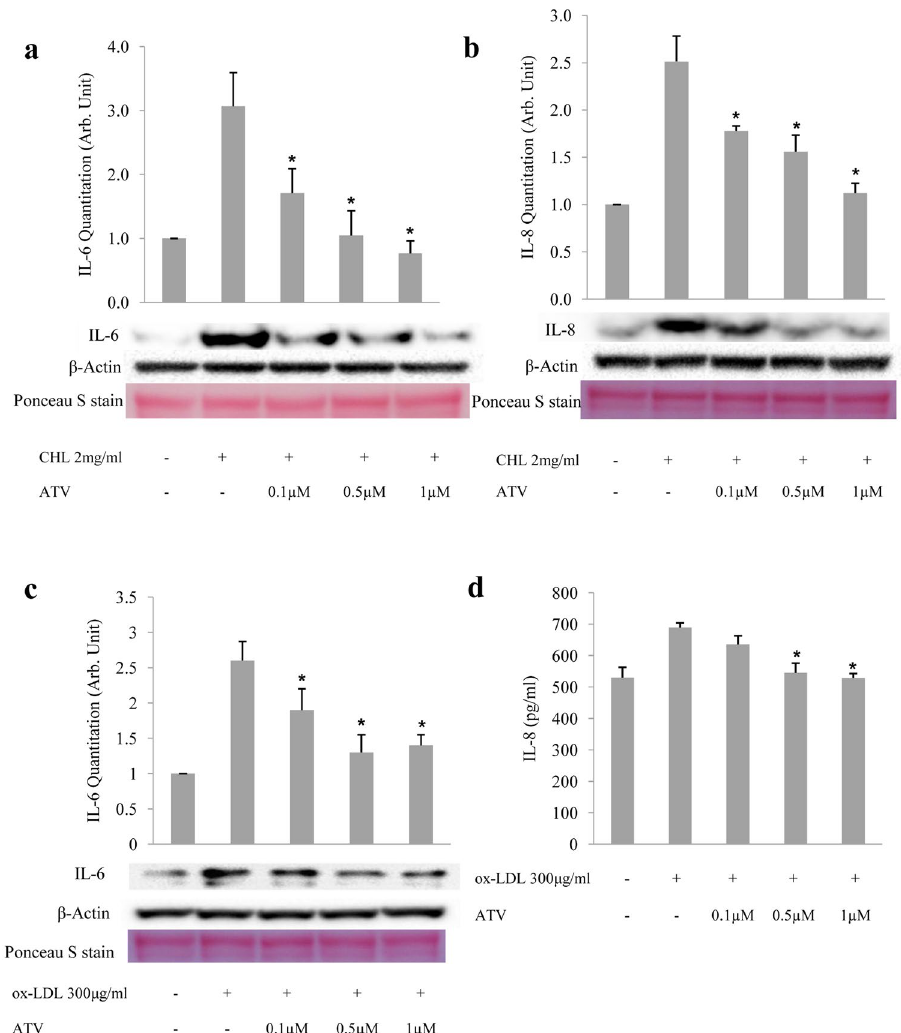
Figure 5. Atorvastatin inhibits IL-6 and IL-8 secretion induced by cholesterol crystals and ox-LDL in ARPE- 19 cells. IL-6 ( a ) and IL-8 ( b ) secretion from ARPE-19 cells as determined by western blot of equal volumes of culture medium 6 hours after treatment with 2 mg/ml of cholesterol crystals (CHL), with or without pretreatment with 0.1, 0.5, or 1 μ M of atorvastatin for 6 hours. IL-6 ( c ) and IL-8 ( d ) secretion from ARPE-19 cells, as determined by western blot and ELISA, respectively, of equal volumes of culture medium 18 hours after treatment with 300 μ g/ml of ox-LDL, with or without pretreatment with 0.1, 0.5, or 1 μ M of atorvastatin for 6 hours. β -actin was detected in each cell lysate. The levels of IL-6 and IL-8 are calculated after normalization against the intensity of β -actin bands. Ponceau S staining was conducted to confirm equal loading. ELISA data were normalized against the cell number. * p < 0.05 versus only CHL or ox-LDL treated group. The results are expressed as mean ±